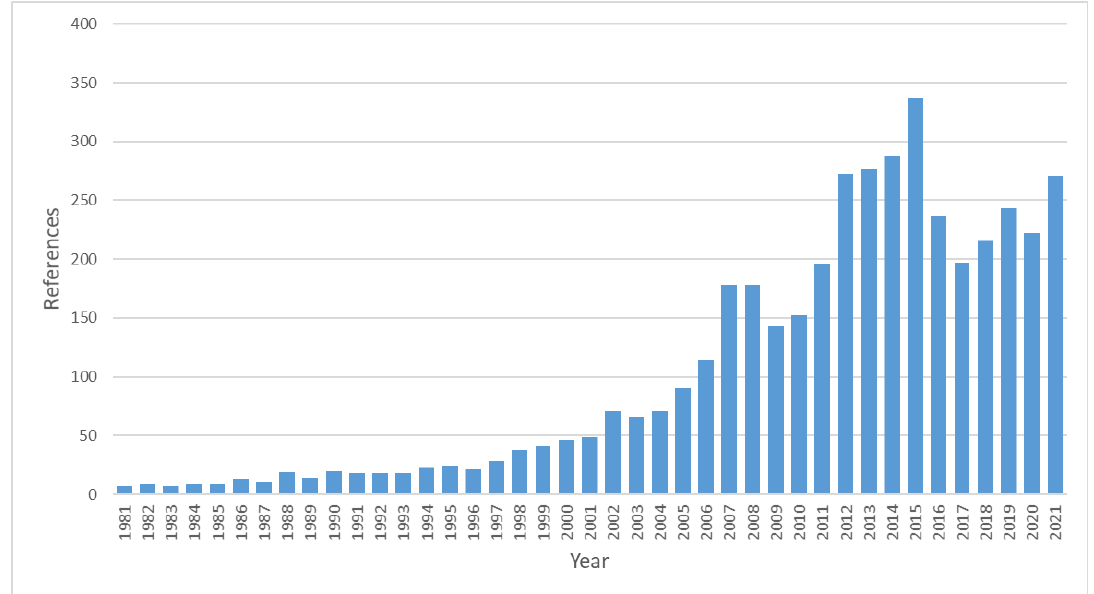
Figure 1. Number of references relative to brewers’ spent grain as retrieved by Sci-Finder n (CAS, American Chemical Society) on 8 March 2022.